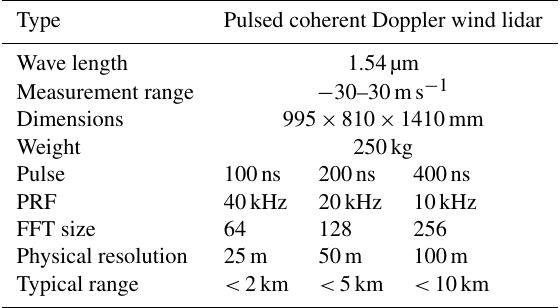
Table 1. Leosphere Windcube 200S specification overview. PRF stands for pulse repetition frequency; FFT stands for fast Fourier